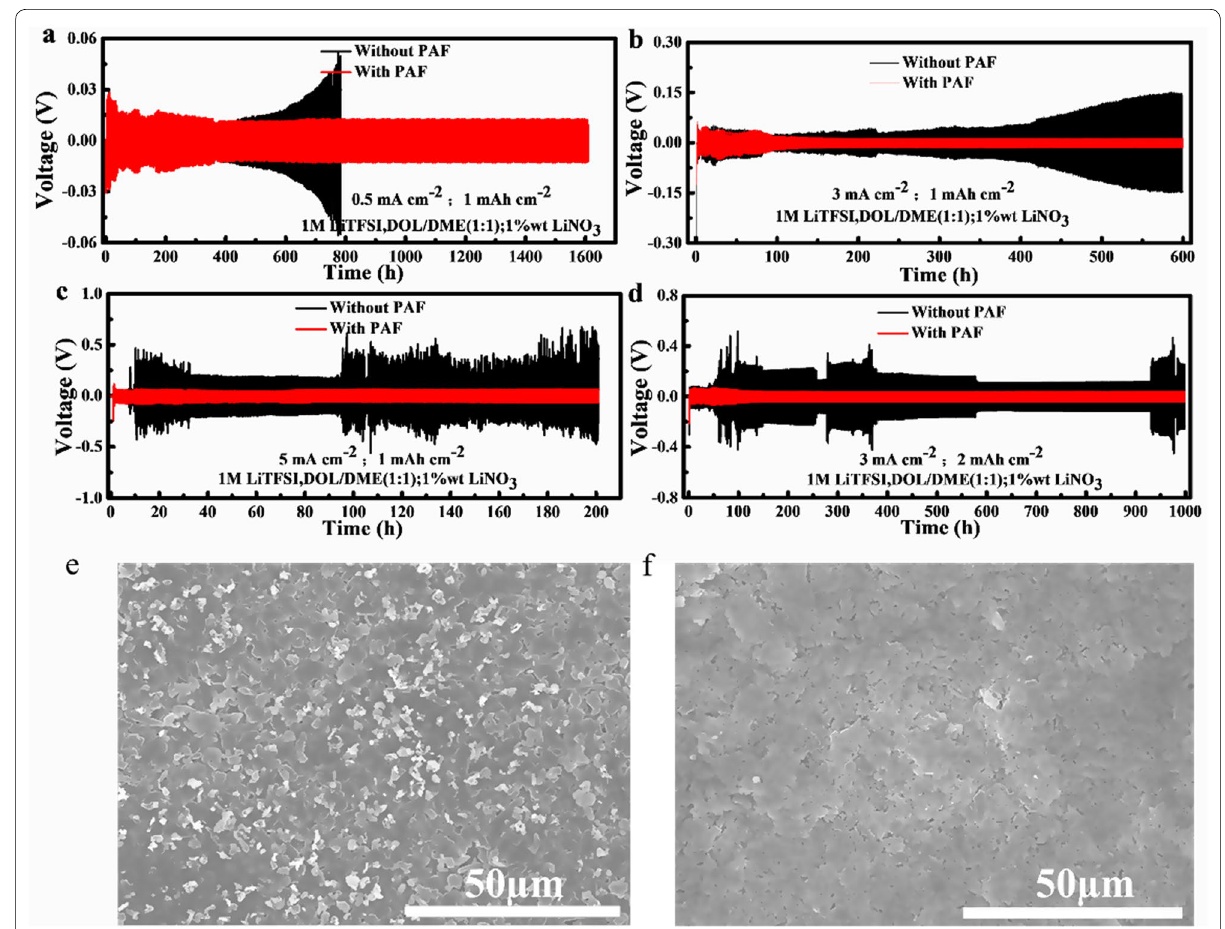
Fig. 3 Galvanostatic plating/stripping profiles of symmetric cells at different current densities: a 0.5 mA cm − 2 (capacity: 1 mA cm − 2 ); b 3 mA cm − 2 (capacity:1 mA cm − 2 ); c 5 mA cm − 2 (capacity:1 mA cm − 2 ) and d 3 mA cm − 2 (capacity: 2 mA cm − 2 ). SEM images of e bare Li foil and f PAF-protected Li foil after 200 cycles at 5 mA cm − 2 (capacity: 1 mA cm − 2